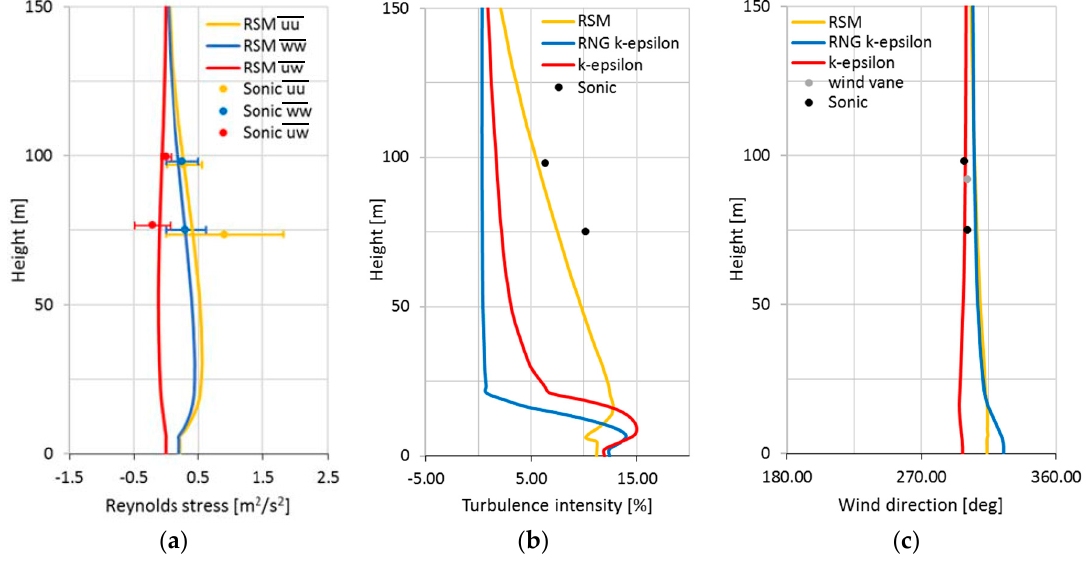
Figure 12. ( a ) Reynolds stresses; ( b ) turbulence intensity; ( c ) wind direction.